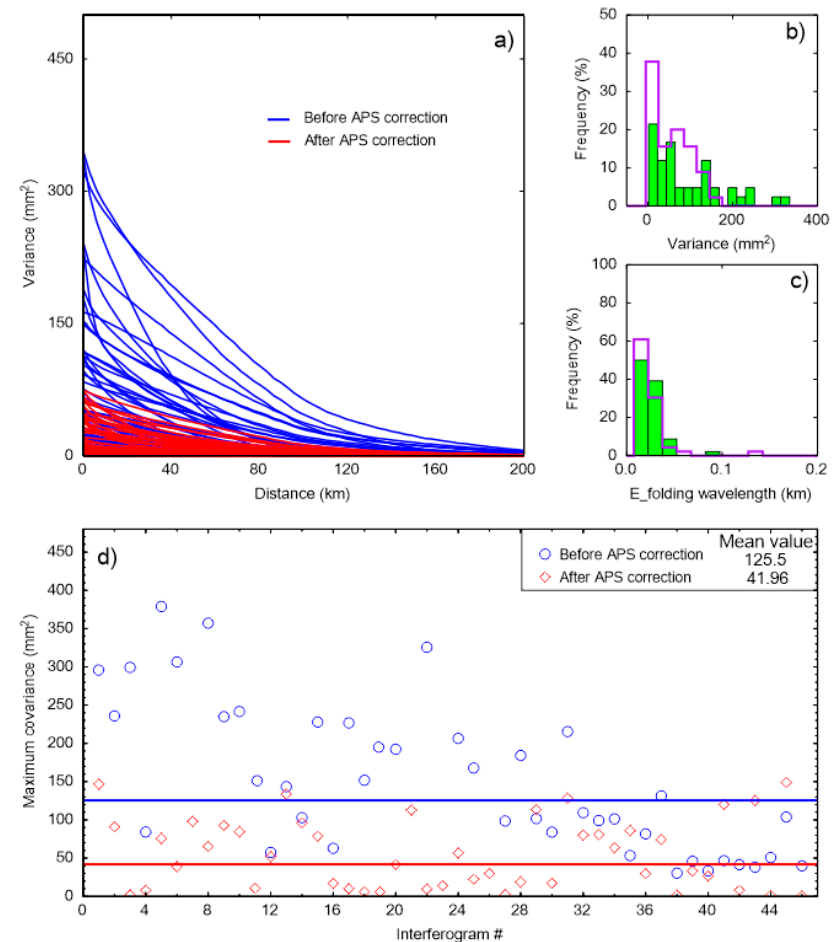
Figure 4. ( a ) Covariance as an exponential function of distance for 44 interferograms on track 176 before (blue) and after (red) atmospheric phase screen (APS) correction; ( b , c ) Variance and e-folding wavelength of the exponential function for the interferograms on track 176 before and after (green filled and purple unfilled histograms, respectively) APS correction; ( d ) Maximum covariance of the interferograms on track 176 before (blue circles) and after (red diamonds) APS correction. Lines indicate the mean values of all the maximum covariences before (blue) and after (red) APS correction.